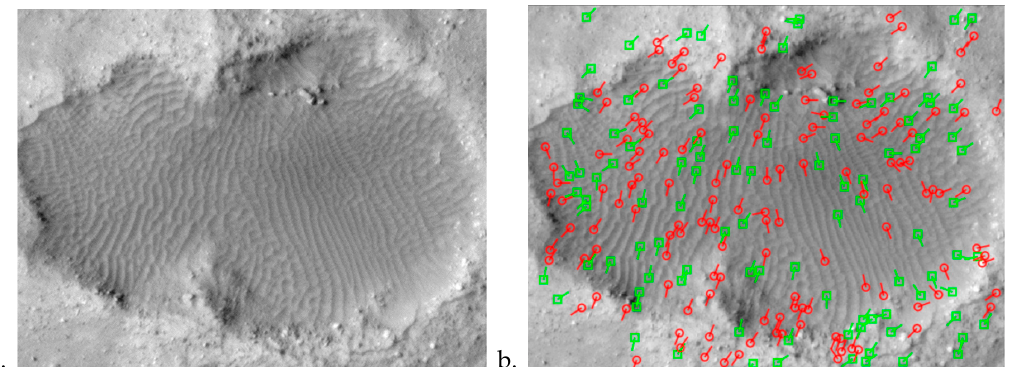
Figure 13. Site L09-10 (175.613, − 14.514 decimal degrees, − 260,101.2515 m, − 860,177.3776 m, Projection Figure 13. Site L09 ‐ 10 (175.613, − 14.514 decimal degrees, − 260101.2515 m, − 860177.3776 m, Projection GCS_Mars). a. Raw image. b. Enhanced MINDTCT processed image. Color key same as Figure GCS_Mars). ( a ) Raw image. ( b ) Enhanced MINDTCT processed image. Color key same as Figure 10.